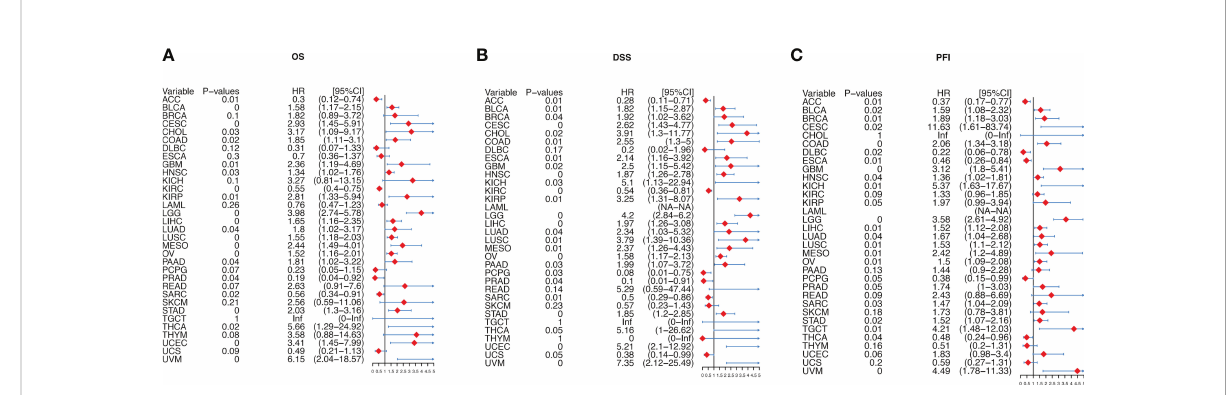
FIGURE 6 Migrasome scores are strongly correlated with patient prognosis. (A) Forest plot shows univariate Cox regression fi ndings of migrasome on overall survival in The Cancer Genome Atlas (TCGA) pan-cancer. (B) The Forest plot shows the univariate Cox regression fi ndings of migrasome on disease-speci fi c survival in TCGA pan-cancer. (C) The Forest plot shows the univariate Cox regression fi ndings of migrasome on the progression-free interval in TCGA pan-cancer. The red color represents signi fi cant